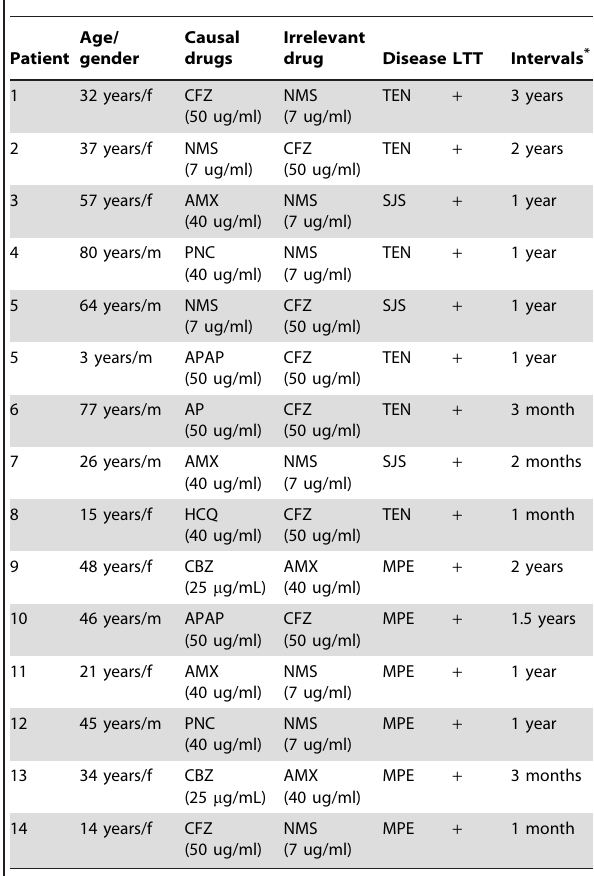
Table 1. Patient